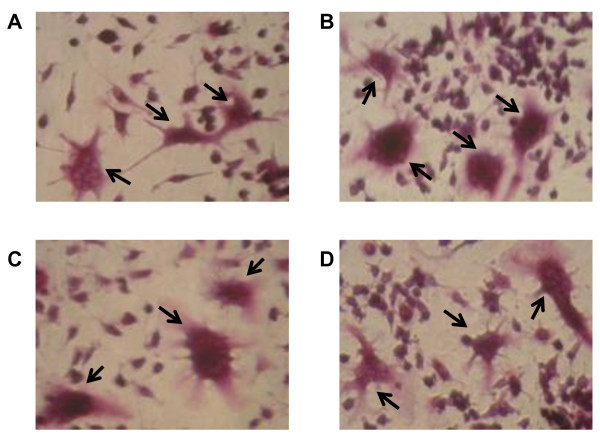
Effect of silica particles on the RANKL-induced osteoclast differentiation in RAW264.7 cells (TRAP staining). RAW264.7 cells were incubated with 10 μg/ml silica particles and 30 ng/ml RANKL for 5 days. Osteoclast genesis was confirmed by TRAP staining. (A) RANKL alone (30 ng/ml), (B) nSP70 10 μg/ml with RANKL 30 ng/ml, (C) nSP300 10 μg/ml with RANKL 30 ng/ml, (D) mSP1000 10 μg/ml with RANKL 30 ng/ml. Arrows show osteoclast cells (TRAP-positive multinucleate cells (> 3 nuclei)). Magnifications of all photographs are ×400.